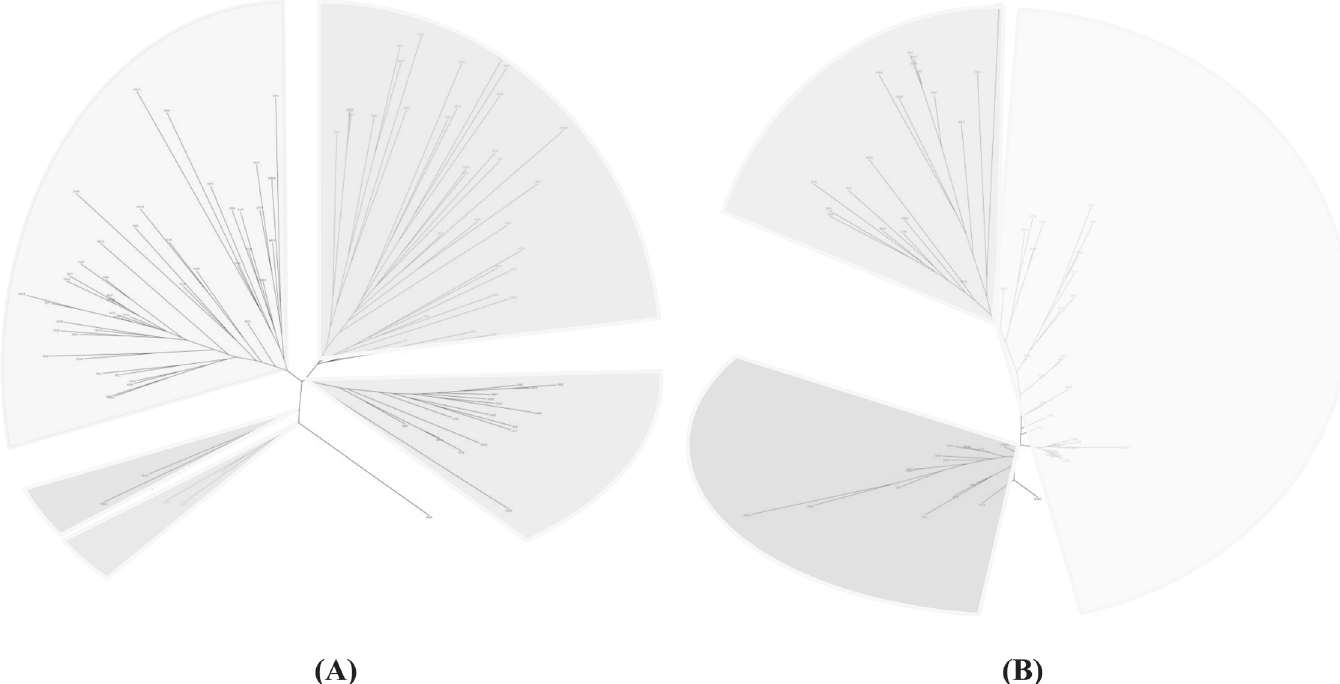
Fig 5. PRIDE2 structure comparison of non-redundant repeat proteins (Drawtree). The repeat proteins are divided into branches, which are shown as groups (A) AR (B)